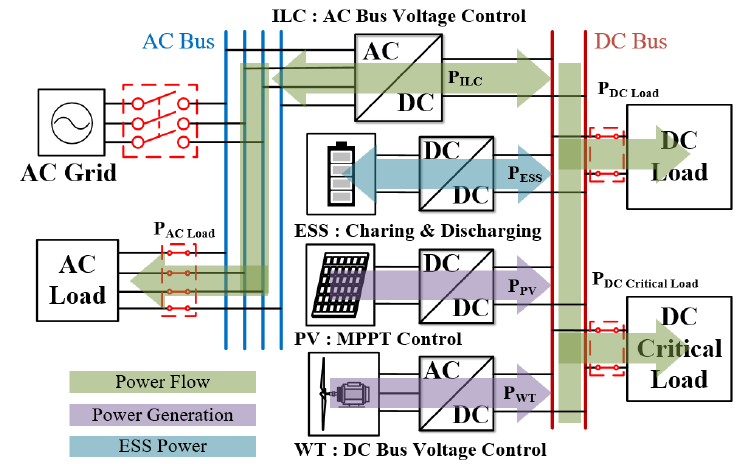
Figure 12. Mode 3: Standalone operation.